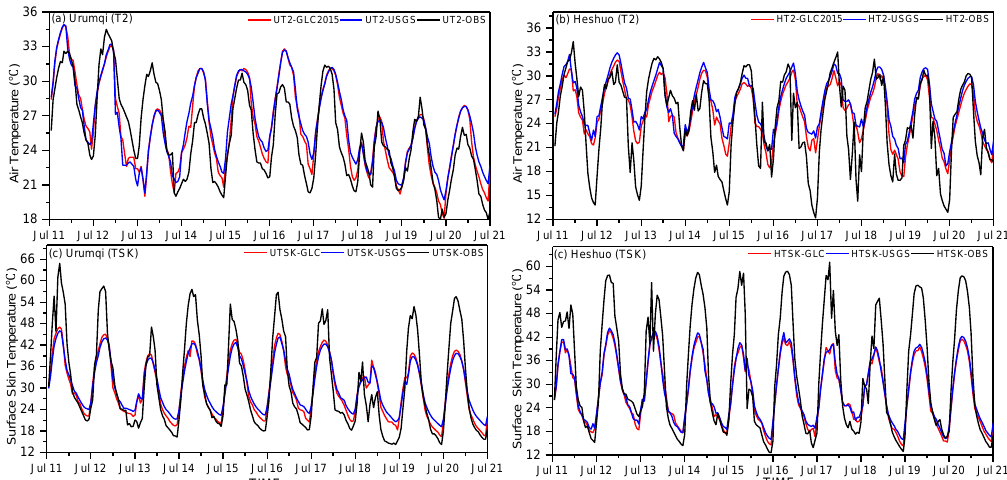
Figure 8. Air temperature ( T 2) at ( a ) Urumqi and ( b ) Heshuo, and the surface skin temperature ( T SK ) at ( c ) Urumqi and ( d ) Heshuo. Both GLC2015 (red line) and USGS (blue line) are shown.